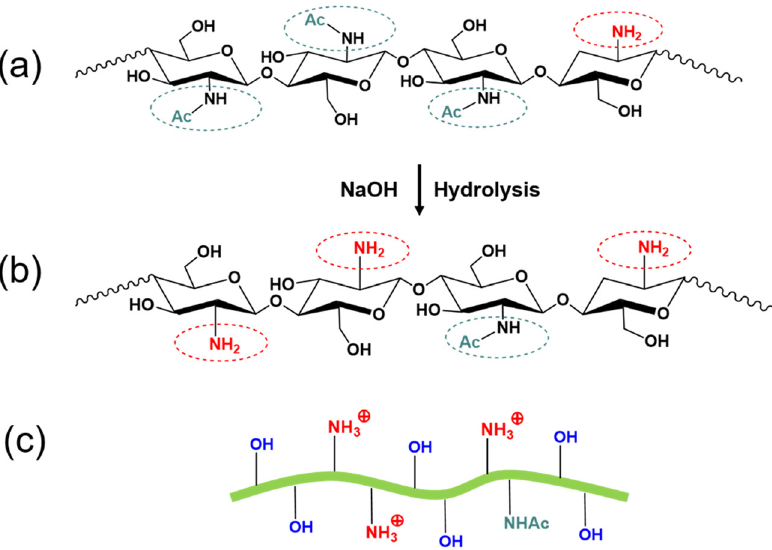
Figure 7: ( a ) Chemical structure of unmodi fi ed chitin; ( b ) chemical structure of partially deacetylated chitin; ( c ) scheme of partially deacetylated chitin nano fi bers with protonated amino groups at pH 3 –